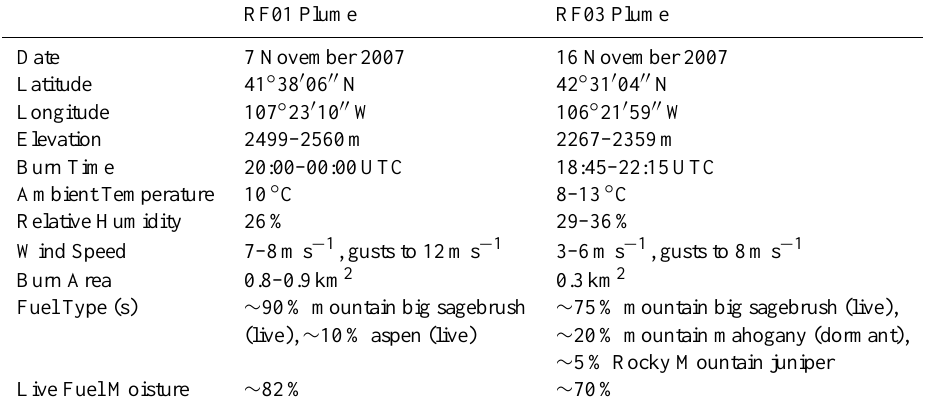
Table 1. Prescribed burn and ground conditions, provided by the Wyoming BLM, for the RF01 and RF03 smoke plumes.